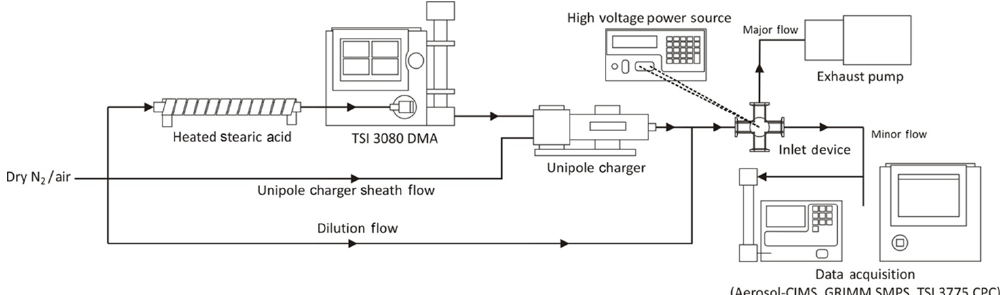
Figure 4. Experimental setup for evaluation of concentration gain from the electrostatic focuser.